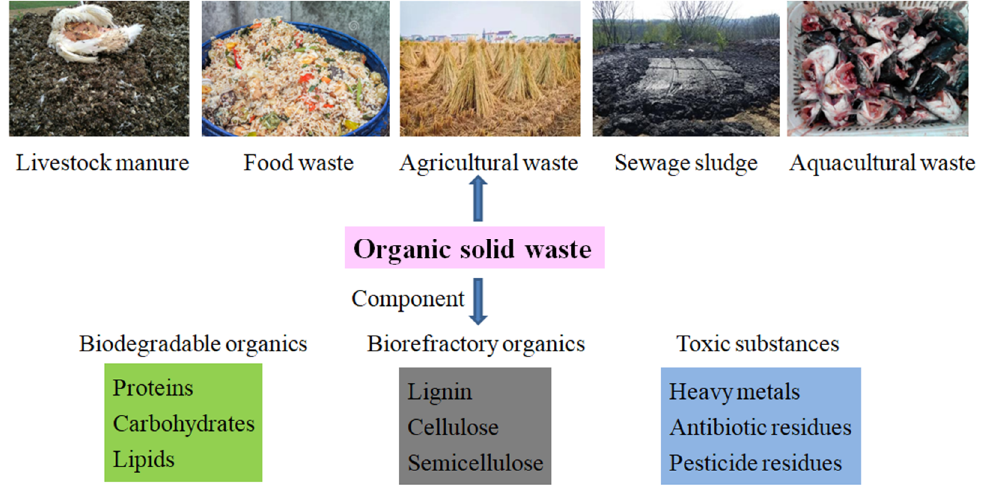
Figure 1. The categories and components of organic solid waste (images by Yuqi Wu).